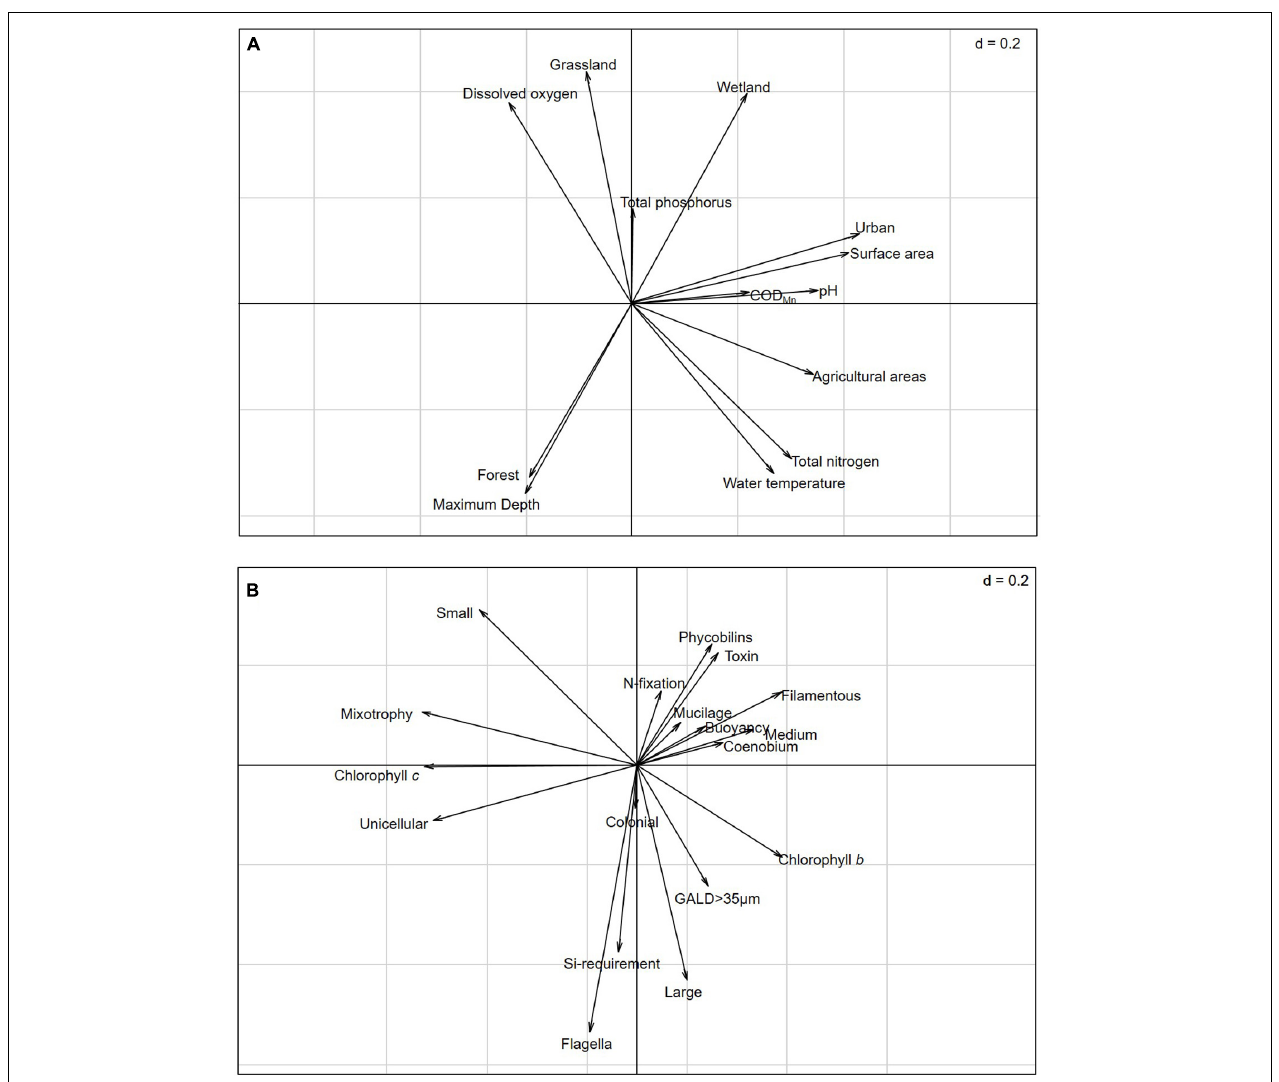
FIGURE 3 | RLQ analysis revealing the correlations between land use and environmental gradient variables (R table 101 × 13) and functional traits (Q table 279 × 18), constrained by species abundance (L table 101 × 279): (A) Coefficients for the land use and environmental gradient variables and (B) coefficients for the functional